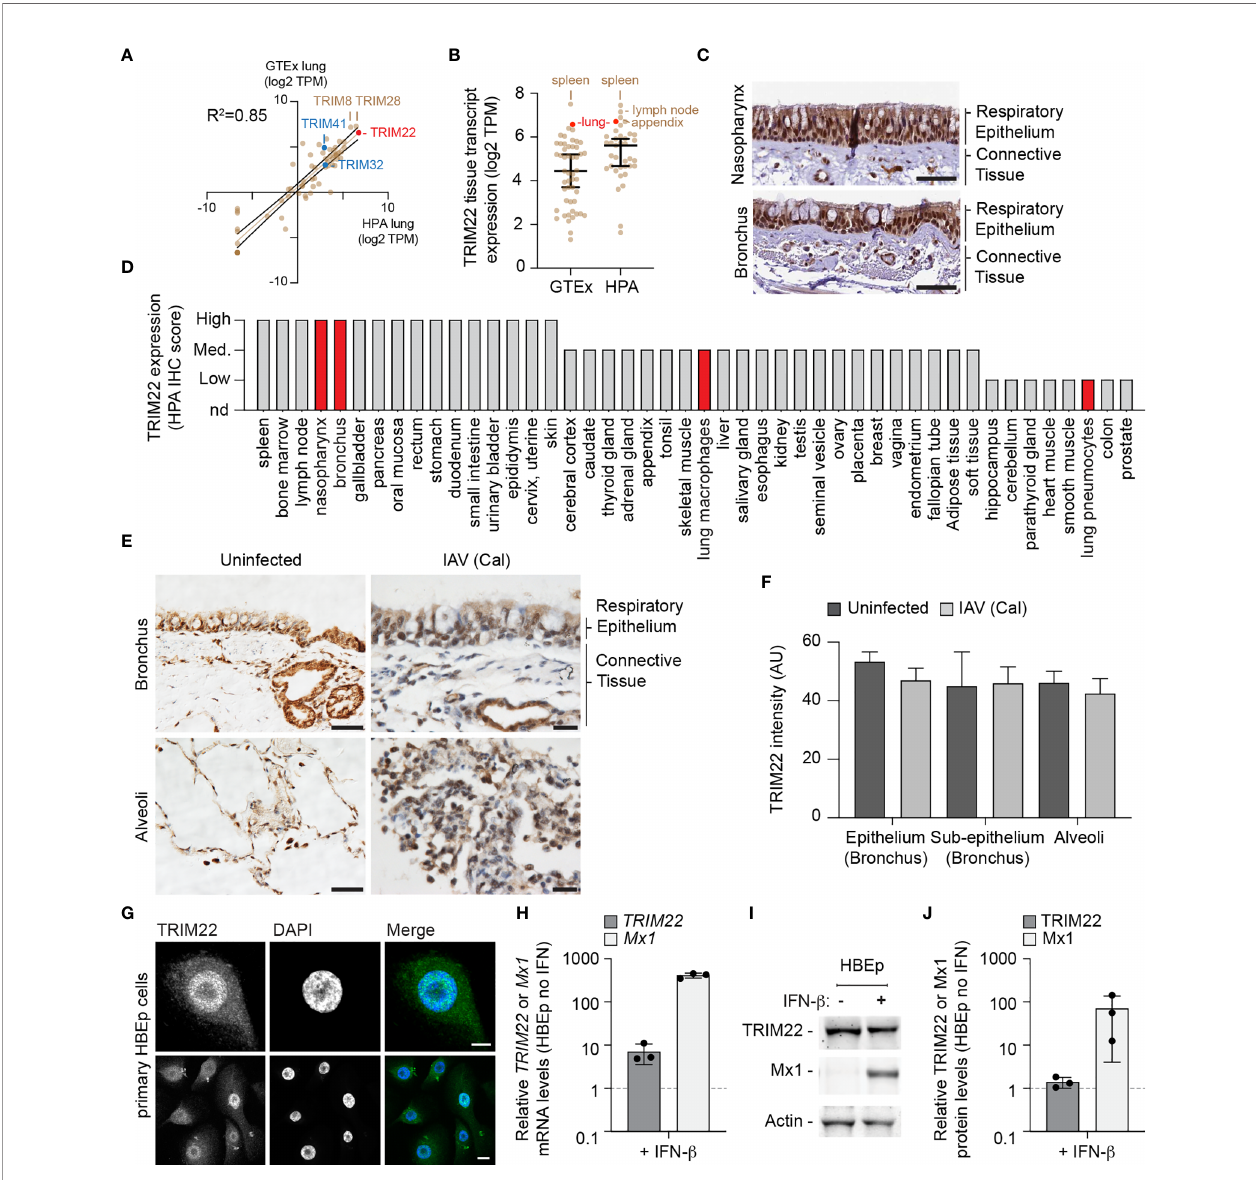
FIGURE 2 | TRIM22 is constitutively expressed in the respiratory tract independently of IAV infection. (A) Scatter plot showing TRIM family member expression levels (log2 TPM) in human lung tissue derived from two independent data sources (GTEx and HPA, respectively; values shown in Supplemental Table S2A ). Solid brown line; linear regression, R-squared (R 2 = 0.85). Solid black lines; 95% con fi dence interval. (B) Scatter plot showing TRIM22 expression levels (log2 TPM) across a range of tissues (as in A ; values shown in Supplemental Table S2B ). Black line: median TRIM22 transcript expression; whisker: 5 th to 95 th percentile range. (C) Histological sections of human respiratory epithelium from the upper (nasopharynx; patient ID 3624) and lower (bronchus; patient ID 3987) airway. TRIM22 is labelled by immunohistochemistry (IHC; brown). Tissues were counterstained with haematoxylin and eosin. Scale bar 50 µm. (D) Quantitation of TRIM22 IHC staining across a range of human tissues. Red bars highlight TRIM22 expression in cells of lung origin. (A – D) Data adapted under creative commons license from GTEx portal [https:// gtexportal.org/home/; (Carithers et al., 2015)] and Human Protein Atlas [HPA; https://www.proteinatlas.org; (Uhlen et al., 2010; Uhlen et al., 2015)]. (E) Histological sections of uninfected or intra-tracheal in fl uenza A virus [IAV; A/California/04/09(H1N1), Cal] infected (6x10 6 PFU) cynomolgus macaques at 5 days post-infection. Tissue sections of respiratory epithelium derived from the bronchus or alveoli were stained for TRIM22 by IHC (brown) and counterstained with haematoxylin. Scale bars; 50 and 20 µm (left and right panels, respectively). (F) Automated quantitation of TRIM22 IHC staining in uninfected or infected cynomolgus macaque respiratory tissue from whole-slide scans (as in E ). Means and SD from four uninfected and three infected animals shown. (G) Confocal images of primary human bronchial epithelial (HBEp) cells stained for TRIM22 by indirect immuno fl uorescence (green). Nuclei stained with DAPI (blue). Scale bars; 10 µm (top panel) and 20 µm (bottom panel). (H – J) Primary HBEp cells were treated with (+) or without (-) IFN- b (100 IU/ml) for 24 h. (H) qRT-PCR of TRIM22 and Mx1 mRNA transcript levels in control or IFN treated HBEp cells. Values normalized to no IFN treatment (dotted line); n=3, means and SD shown. (I) Western blots of HBEp whole cell lysates (WCLs) probed for TRIM22 and Mx1 expression. Actin is shown as a loading control. (J) Quantitation of western blots (as in J ). Values normalized to actin and expressed relative to no IFN treatment (dotted line); n=3, means and SD